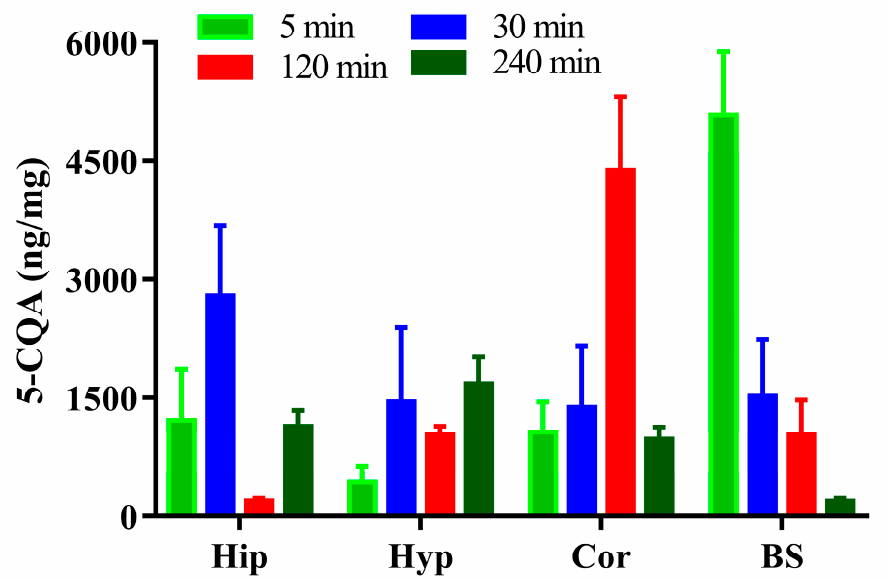
Figure 5. Concentration of 5-CQA in the rat hippocampus, hypothalamus, cortex, and brainstem after vein injection of 50 mg/kg 5-CQA.